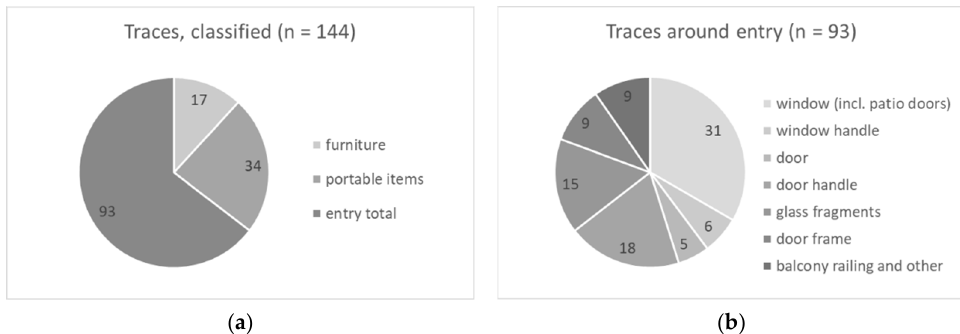
Figure 1. ( a ) All samples classified in three categories; ( b ) samples from entry divided in several sub-classes.